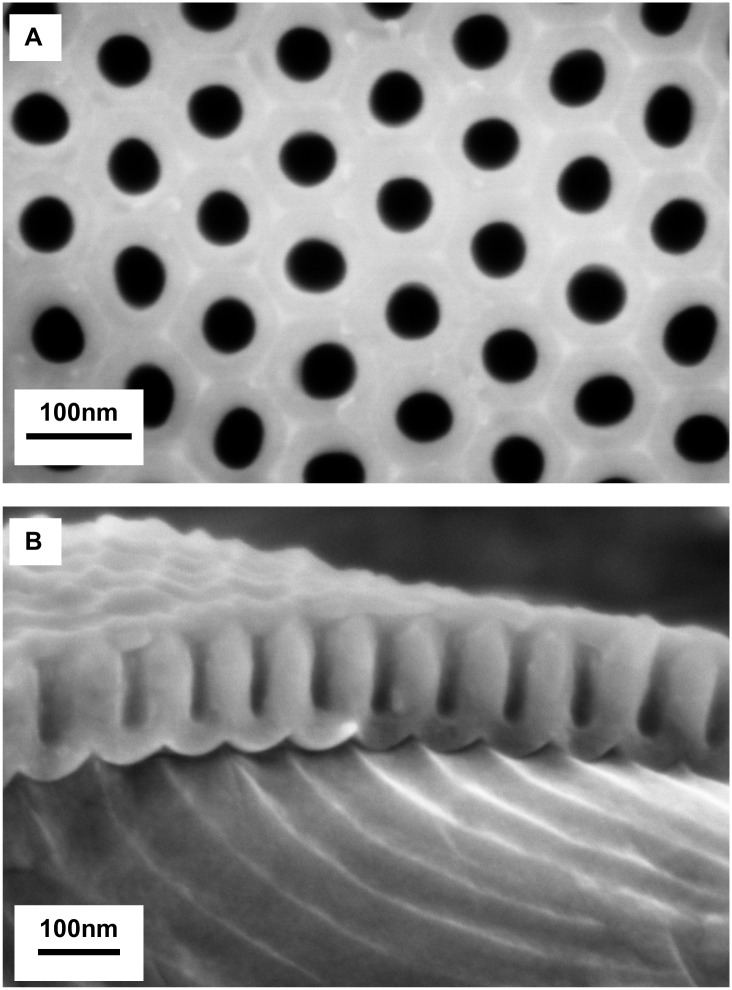
SEM images of AAO mold.(A) top view with 50 nm diameters and 100 nm interpore distances (B) cross-section view with pore lengths of about 100 nm